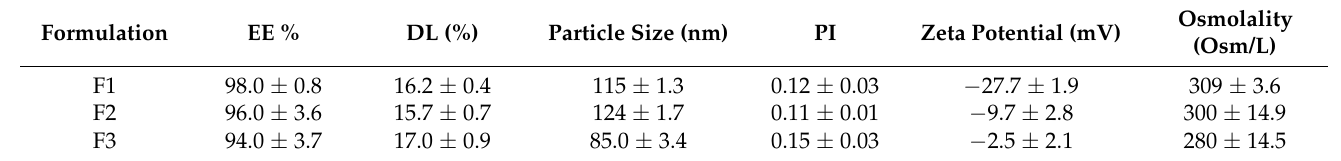
Table 1. Physicochemical characteristics of different liposome formulations. Values are expressed as mean ± SD, n =